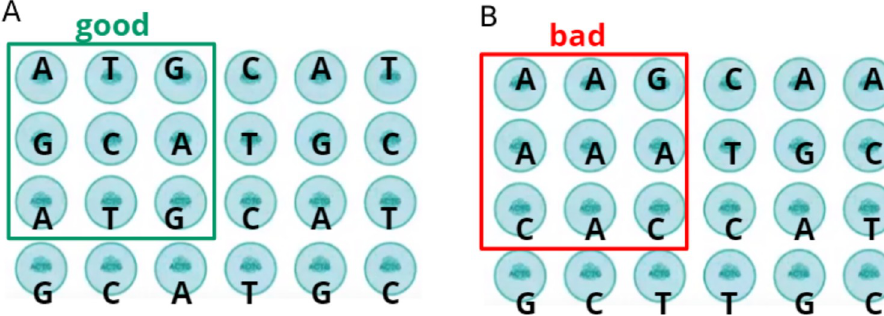
Fig 6. Schematic representation of the DNB on the flow cell. An ordered structure of DNB, each one is shown as a circle. The letter denotes the outer nucleotide on the nanoball to be identified in the current cycle. A–the level of radiation from each nucleotide type is approximately the same, the identification of nucleotides is successful, B–there is an overrepresentation of one of the nucleotide types and an underrepresentation of others, which leads to illumination and identification